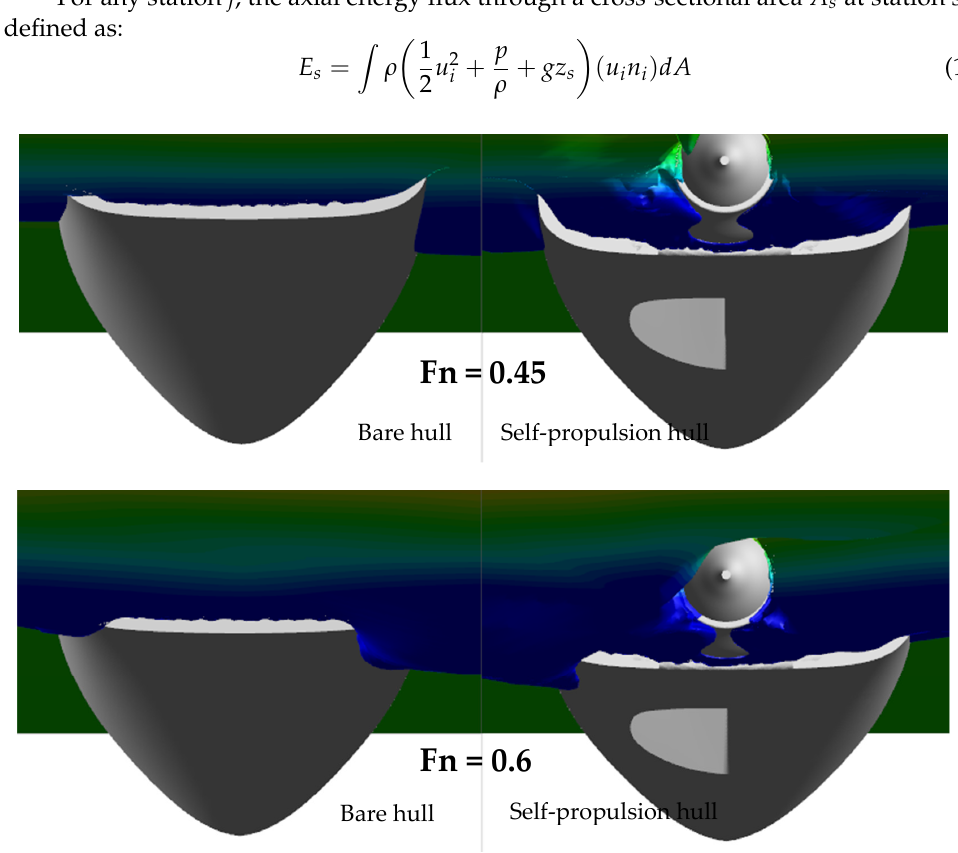
Figure 27. Comparison of the immersed transom area of hull.